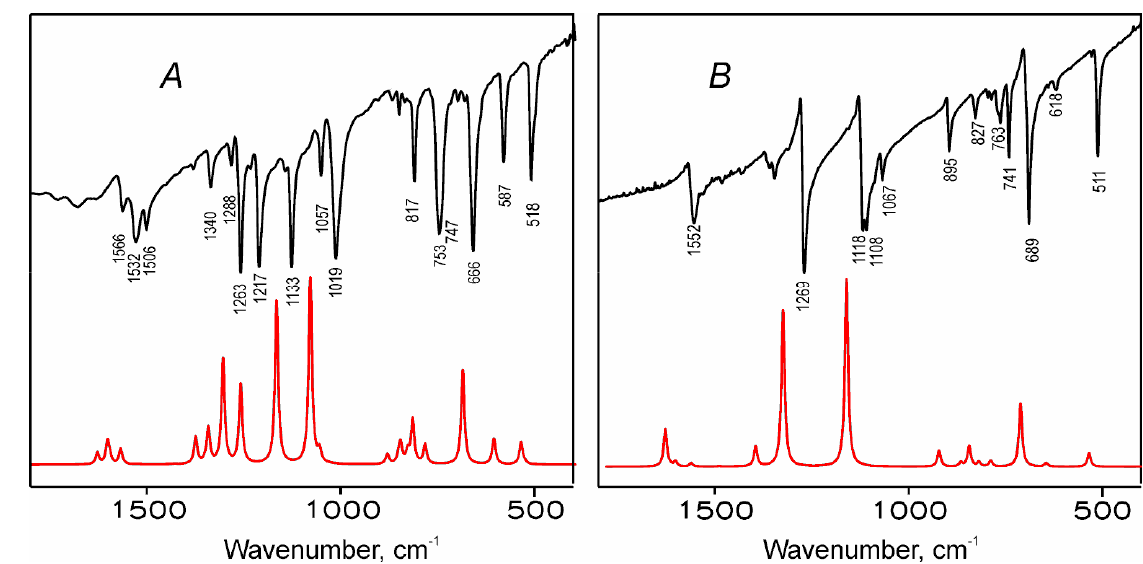
Figure 9. Comparison of the experimental (black lines) and simulated (red lines) IR spectra of H 2 TTDPz ( A ) and NiTTDPz ( B ). Table 6. Assignment of the IR vibrations of the H 2 TTDPz and NiTTDPz molecules. Frequency, cm − 1 I rel , % Symmetry